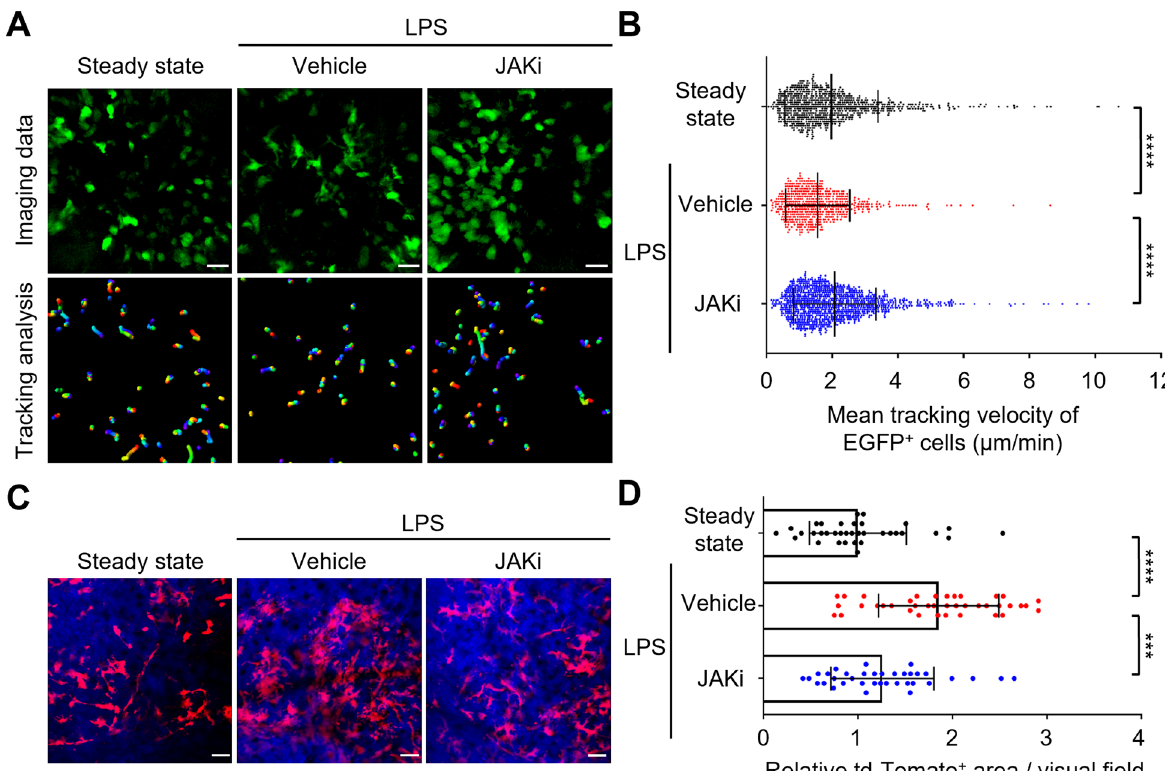
Fig. 2 JAK inhibitor influenced migration of osteoclast precursors to the bone surface. A Representative intravital multiphoton imaging of the migration of osteoclast precursors in calvarial bones in JAK inhibitor (JAKi)-treated LPS-induced mice. Green, CX 3 CR1-EGFP. Scale bar, 30 µm (upper panels). The movement of CX 3 CR1-EGFP + cells was tracked for 10 min. Colored lines show the cell trajectories (lower panels). B Tracking velocities of EGFP + cells (steady state, n 795 cells; vehicle, n 570 cells; JAKi, n 1091 cells from 5 mice per group). C Representative intravital multiphoton = = = imaging of mature osteoclasts in calvarial bones in JAK inhibitor (JAKi)-treated LPS-induced mice. Red, TRAP-tdTomato + mature osteoclast; blue, bones (second harmonics generation). Scale bar, 50 µm. D Area of TRAP-tdTomato + mature osteoclasts relative to steady state (steady state, n 35 images; vehicle, n 39 images; JAKi, n 36 images from 5 mice per group). Error bars indicate the means SDs. Statistical significance was = = = ± determined by Kruskal-Wallis test. *** P <0.001, **** P <0.0001